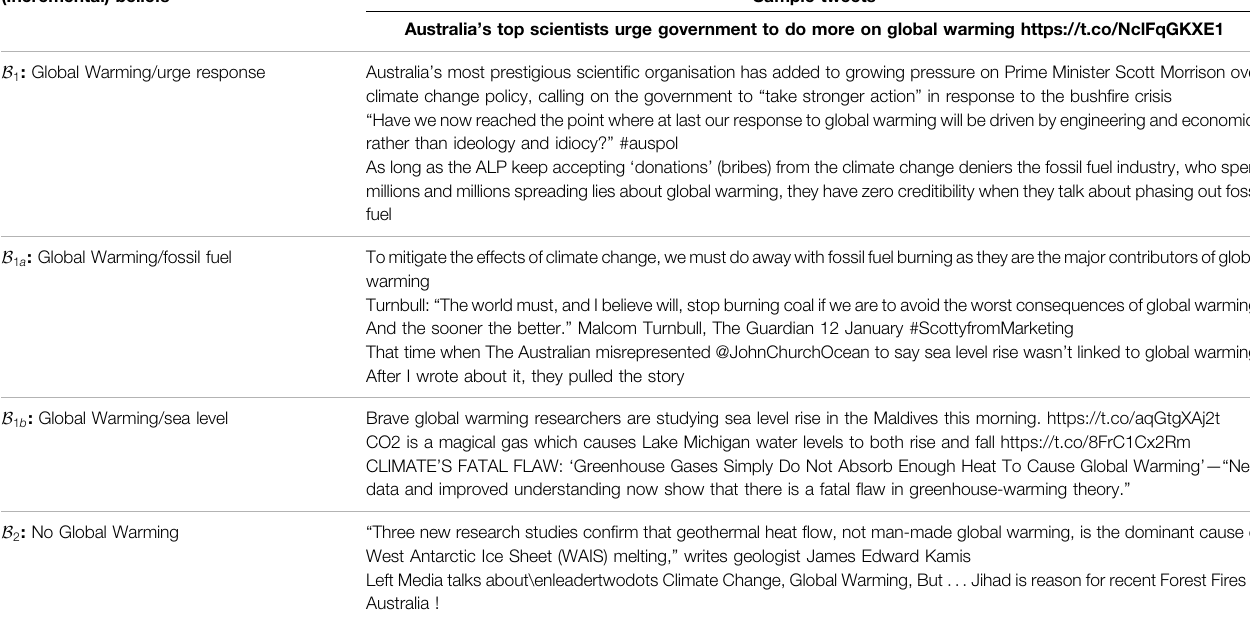
TABLE 7 | Top 3 tweets from separated beliefs (global warming). (Incremental) beliefs Sample